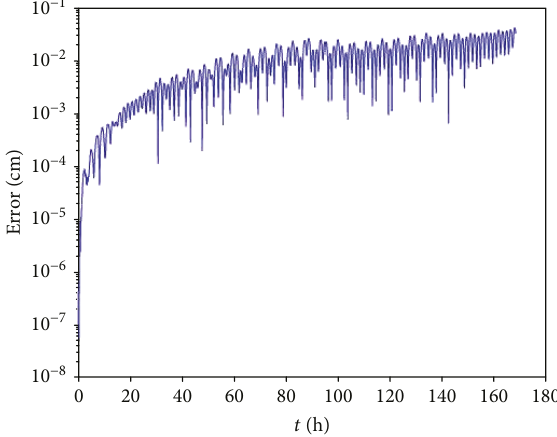
=10 − 13 Figure 9: Di ff erence between relative Newtonian positions of D r with respect to S computed with TOL